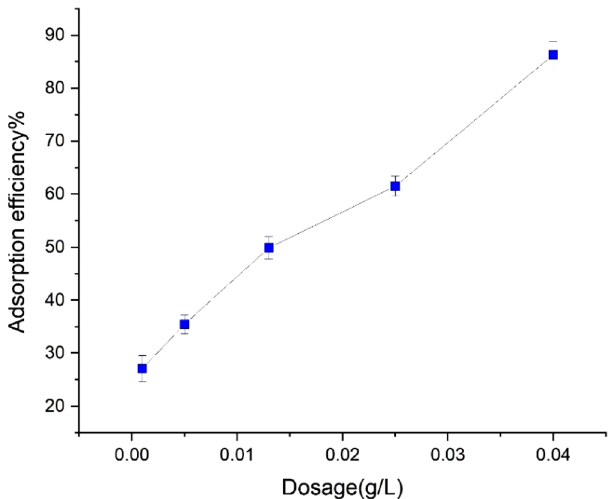
Figure 9. Effect of adsorbent dosage on Pb(II) adsorption (pH of 6, Pb(II) concentration (20 ppm), contact time (60 min), volume of the solution (40 ml), adsorbent dosage range of (0.001–0.04 g), and temperature of 298